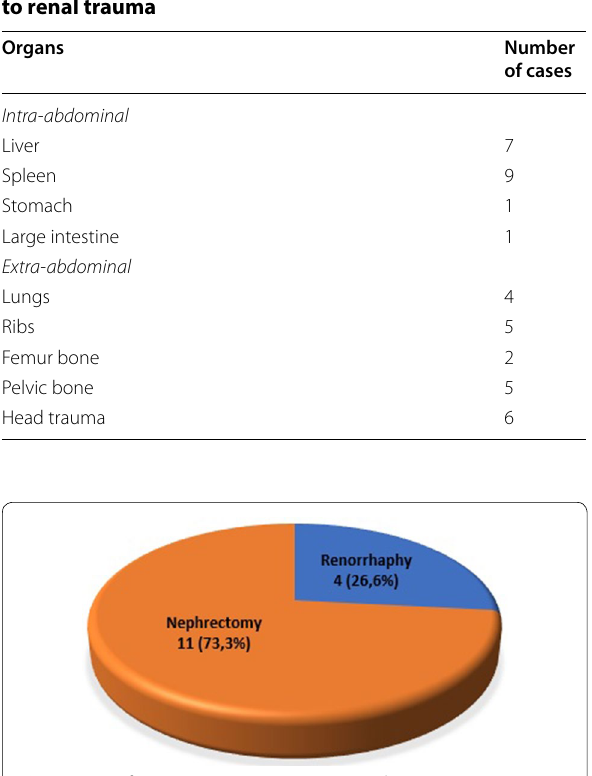
Table 3 Injuries of other associated organs related